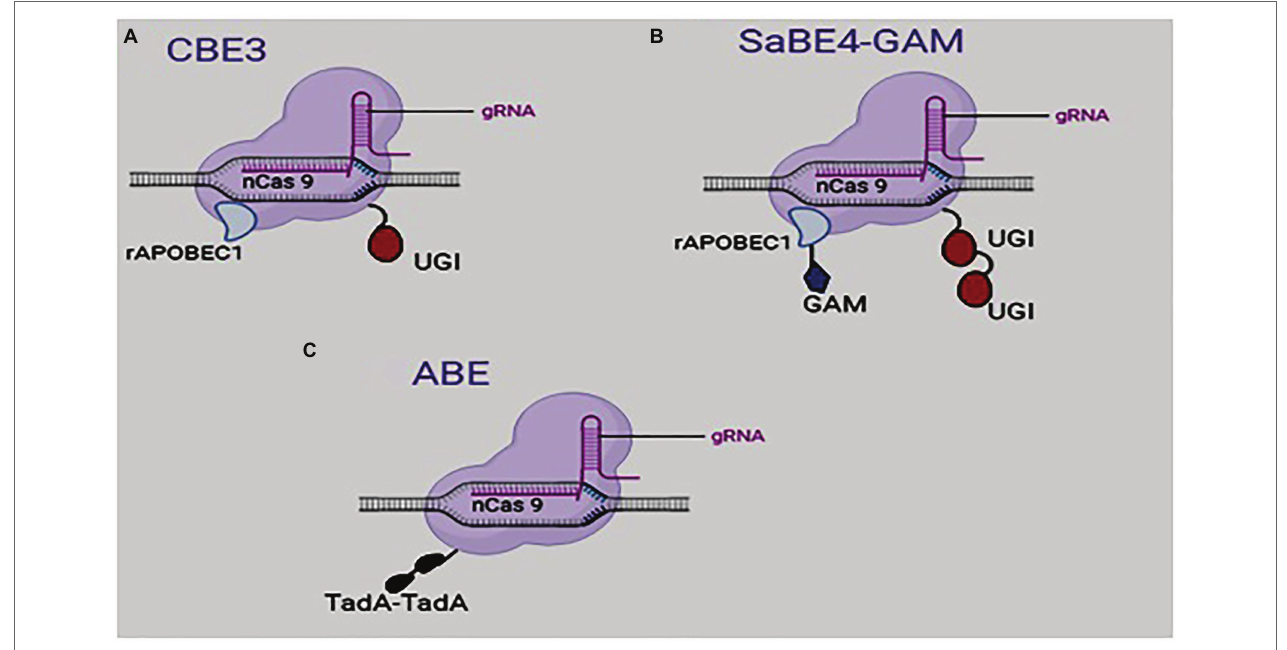
FIGURE 2 | Structure of some developed base editors: (A) Cytosine base editor (third generation), (B) Staphylococcus aureus Cas9-derived BE4 and (C) adenosine base